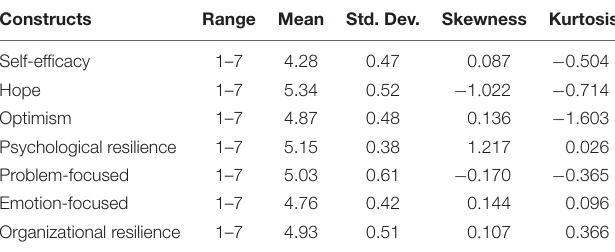
TABLE 2 | Descriptive statistics.